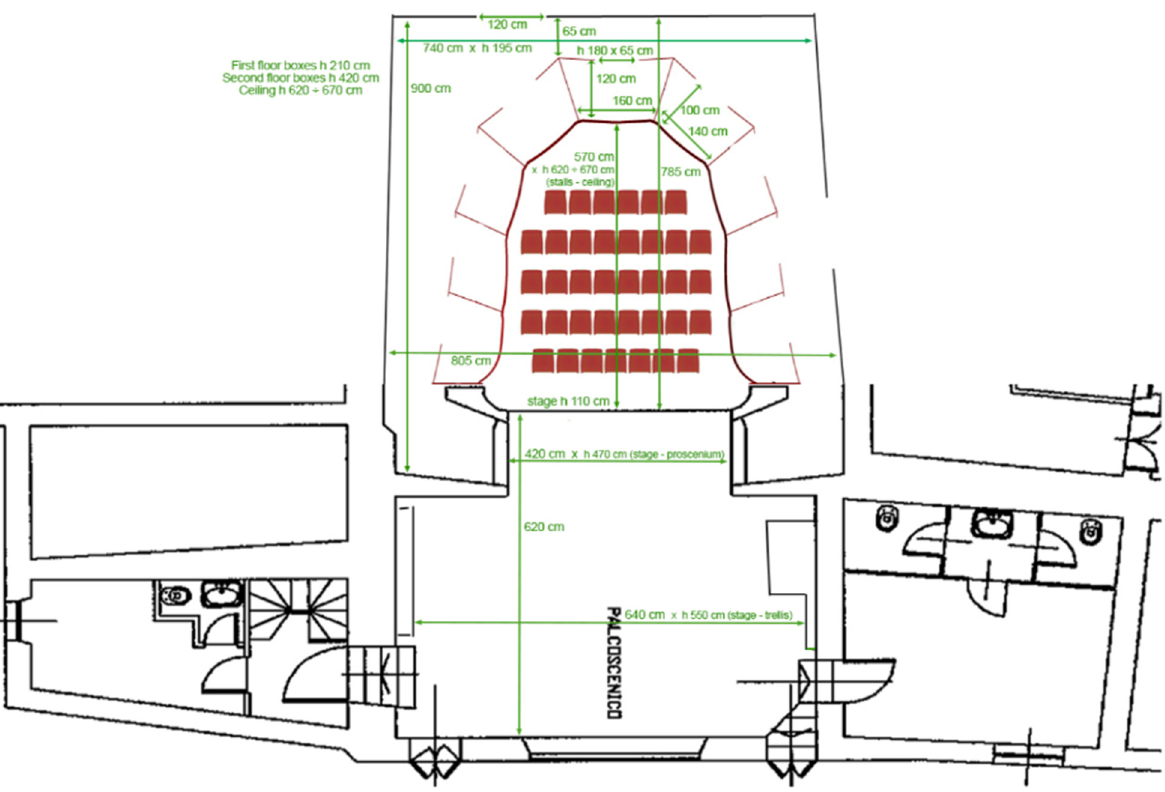
Figure 3. Plan layout of ground floor.